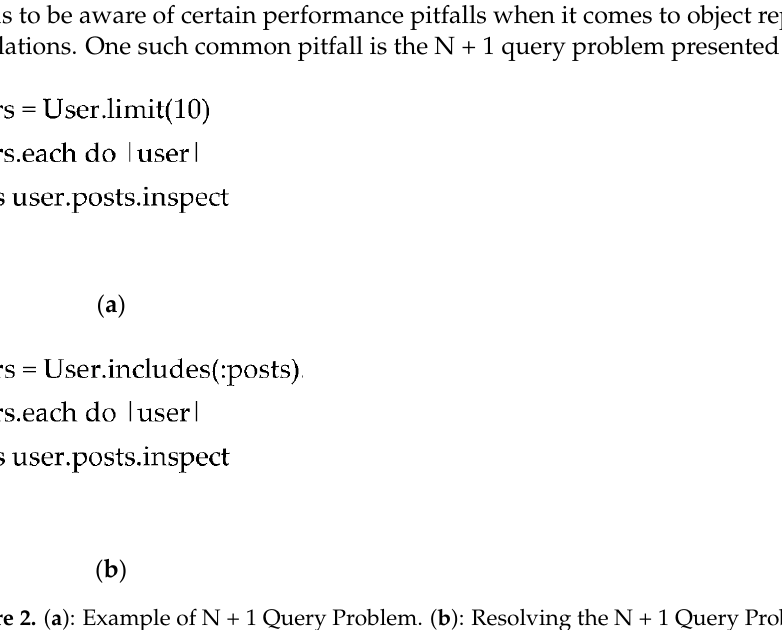
Figure 2. ( a ): Example of N + 1 Query Problem. ( b ): Resolving the N + 1 Query Problem using the includes() function.